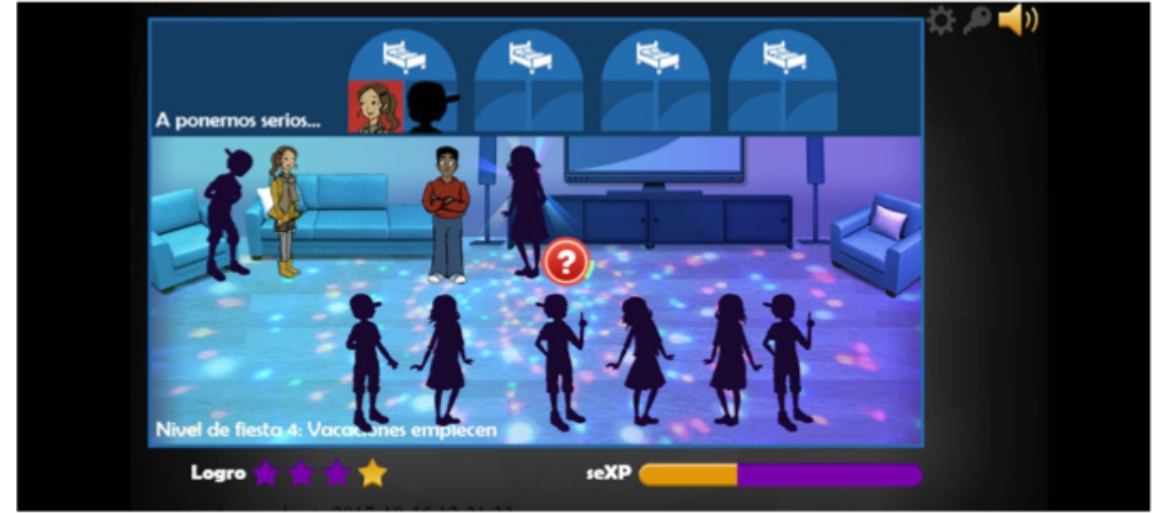
Figure 2. Screenshot from Colegio del Sexperto (Sexpert High School) video game illustrating avatars interacting and trivia